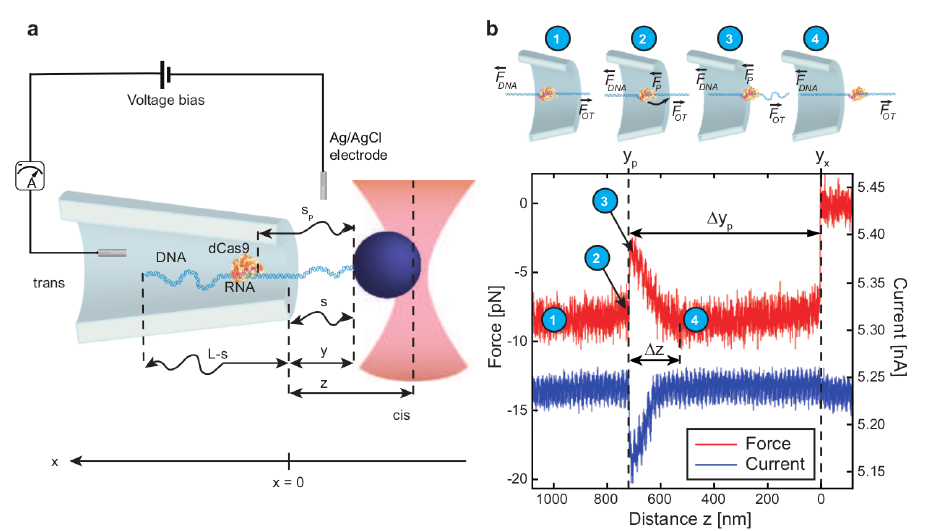
Figure 3. End—pulled translocation of a DNA—protein complex (DPC) through a nanopore using an optical tweezer. ( a ) shows a schematic diagram of a typical experimental set-up, where one end of a polymer is grafted on an optical bead and the motion of this bead is controlled using an optical tweezer ( b ). Cartoon representations of the different stages of translocation are shown in (b1–b4), and the signature of these stages can be traced out as a jump or traps in the recorded current/force vs. distance diagram (bottom panel of ( b )). Reprinted with permission from [158] copyright 2016 by American Chemical